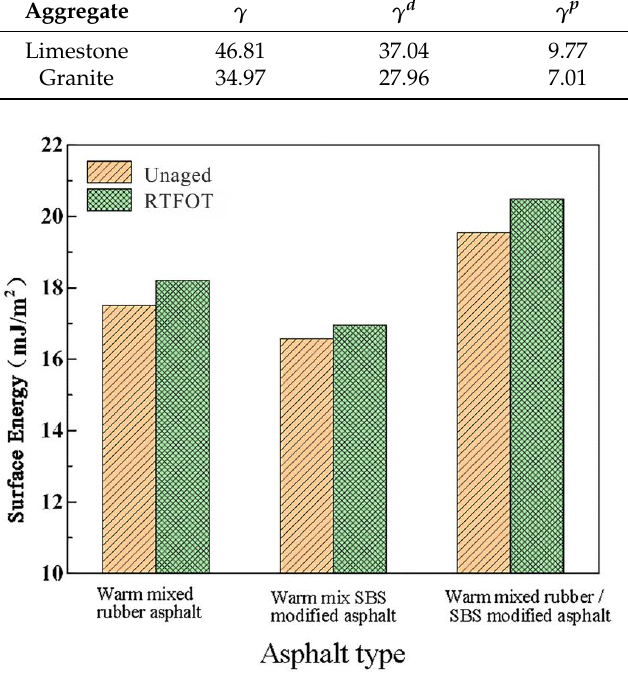
Figure 4. The surface energy of the modified asphalt sample before and after short-term aging. As shown in Figure 4, warm mix crumb rubber/SBS composite modified asphalt ranks above warm mix crumb rubber asphalt and ahead of warm mix SBS modified as- phalt in terms of surface energy under the same aging situation. This is related to the modification mechanism of warm-mix polymer-modified asphalt. The mastic powder swells and creates an interfacial transition layer with the asphalt during the polymer modification process, improving the asphalt ’ s overall performance. Additionally, the fi- ne mastic powder particles in asphalt can spread out internal tensions and increase as- phalt ’ s resistance to breaking. SBS modifiers can physically bond with asphalt during the swelling process so that there is an embedded force between them, improving the cohesiveness of asphalt. The warm-mix crumb rubber/SBS composite modified asphalt demonstrates good cohesive qualities as a result of the interaction between the CRM and SBS modifier, as well as the production of a network structure inside the asphalt. When compared to SBS modification, the mastic powder modification absorbs a lot more light components during the swelling process, increasing the viscosity of the asphalt and im- proving the cohesiveness effect [39,40]. Since the cohesive power and cracking resistance of asphalt increase with surface energy, it can be said that RTFOT aging aids in enhancing warm mix polymer-modified asphalt ’ s cracking resistance. 3.1.3. Adhesion Work The adhesion work characterizes the asphalt-aggregate adhesion performance. Fig- ure 5 displays the adhesion work of an asphalt-aggregate before and after aging based on the asphalt and aggregate ’ s surface energy characteristics.